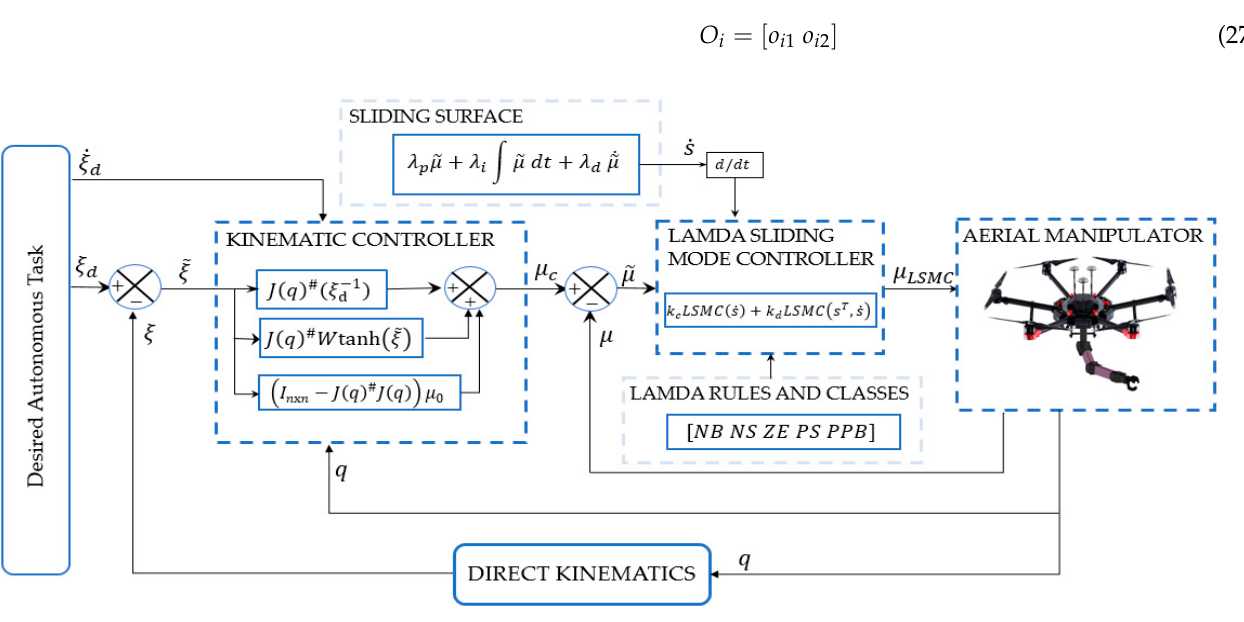
Figure 5. LSMC controller scheme.